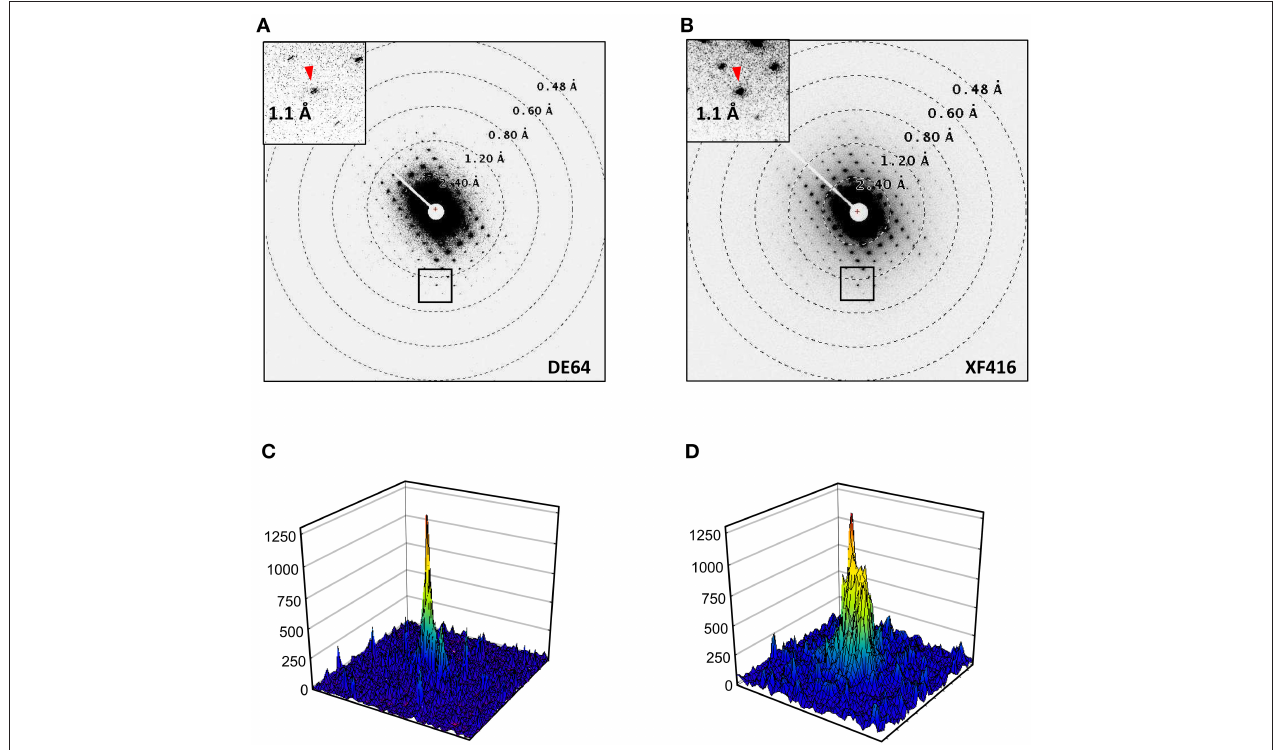
FIGURE 5 | Electron diffraction patterns of a similar molecule to Ph-BTBT-C10. (A) Recorded on the DE64 with the same condition as in Figure 4 except for at 1s exposure/frame. (B) Reordered on the XF416 as in (A) except for a shorter camera length of 400mm. (C) An intensity profiles (62 × 62 pixels) of a diffraction spot referred with an arrow head in (A) . (D) An intensity profile (52 × 52 pixels) of diffraction spot in (B) . The display areas in (C) and (D) were adjusted between the two cameras placed one above the other ( Figure 1 ). Note that the peak profile is sharper and background noise is lower in (C) than those in (D) .